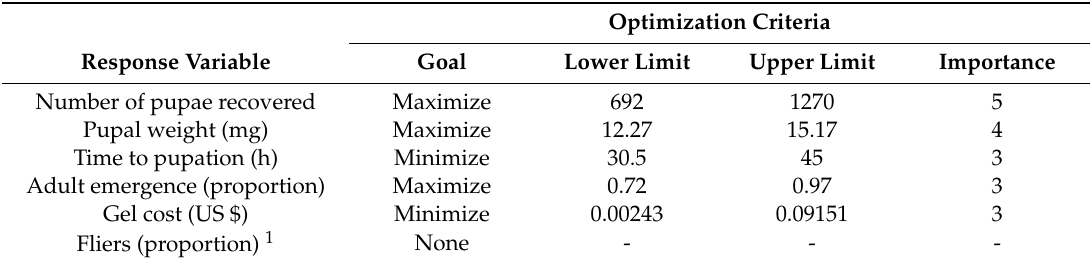
Table2. Optimizationcriteriausedtofindanoptimalgeldietformulationforrearingof Anastrephaludens